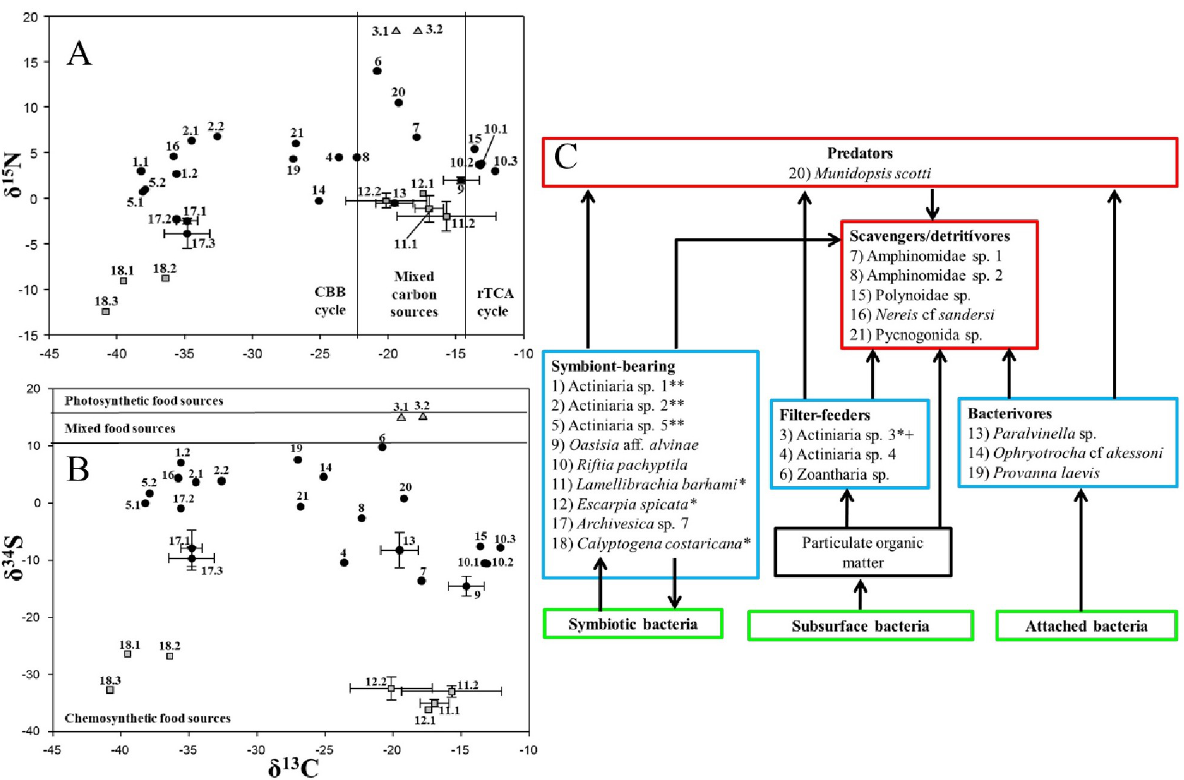
Fig 3. Dual isotope plots showing stable isotope signatures (‰) of macrofaunal species collected in PB and PTF. A) δ 13 C vs . δ 15 N. B) δ 13 C vs . δ 34 S. ● Fauna from PB. ■ Fauna from PTF. ▲ Non-vent fauna. C) Trophic diagram of the macrofauna of PB and PTF � Species from PTF. �� Species whose feeding guild is not confirmed. + Non-vent fauna. Numbers identifying individual points are listed in Table 1 as ID